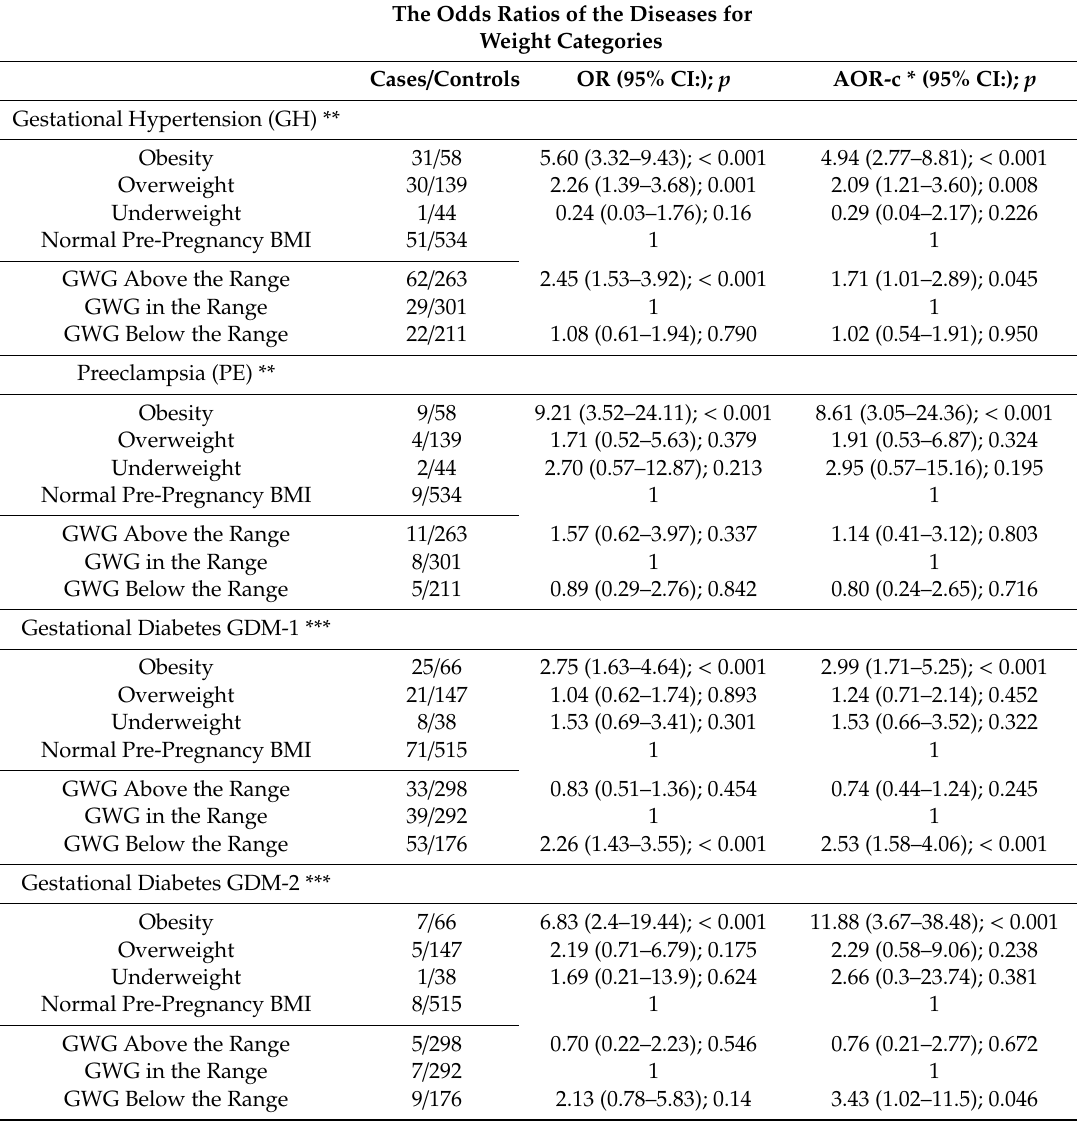
Table 3. The adjusted odds ratios of hypertension and diabetes in pregnancy for various categories of maternal